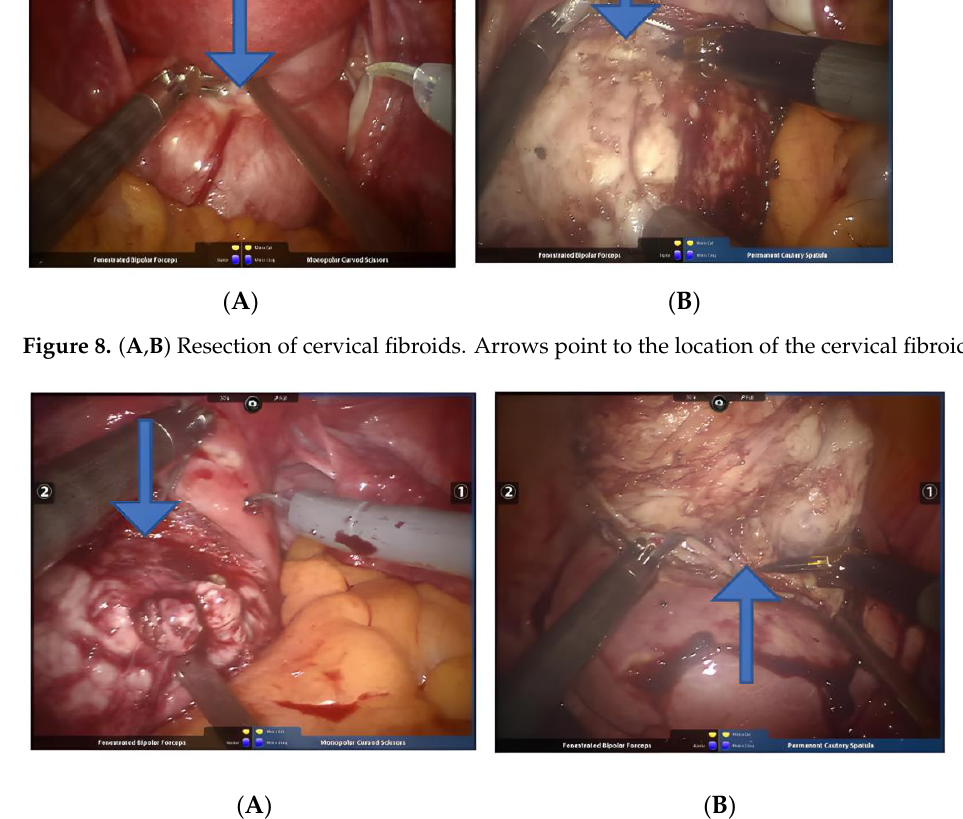
Figure 9. (A,B) Resection of intravascular leiomyoma. Arrows point to the location of the intravascular leiomyoma.